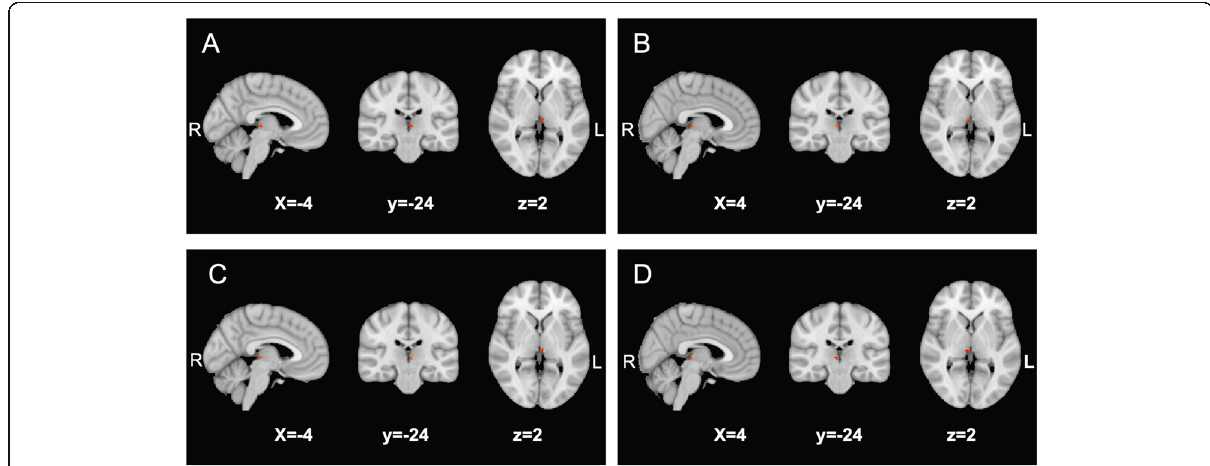
Fig. 3 Altered habenula-SN functional connectivity maps. Altered resting-state functional connectivity of habenula and the SN region in MOH + CM vs. that in HC and EM patients. ( A ) the increased resting-state functional connectivity of the left habenula and the SN in patients with MOH + CM compared with HC; ( B ) the increased resting-state functional connectivity of the right habenula and the SN in patients with MOH + CM compared with HC; ( C ) the increased resting-state functional connectivity of the left habenula and the SN in patients with MOH + CM compared with EM; and ( D ) the increased resting-state functional connectivity of the right habenula and the SN in patients with MOH + CM compared with EM. SN, salience network; MOH + CM, medication-overuse headache + chronic migraine; HC, healthy controls; EM, episodic